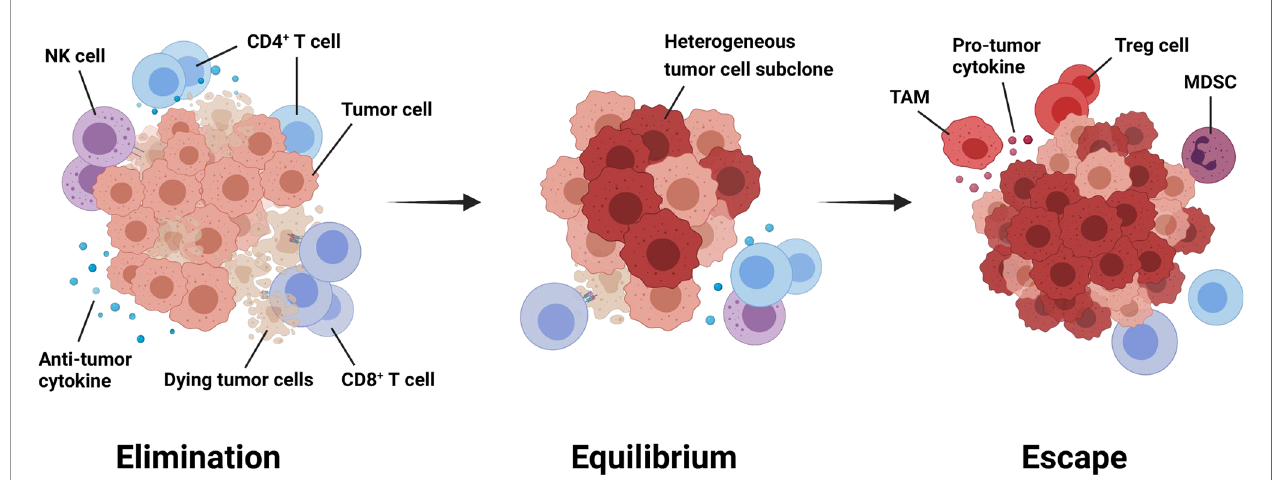
FIGURE 1 | Immunoediting throughout tumorigenesis and progression. Immunoediting generally evolves through three phases: elimination, equilibrium, and escape (14). During the fi rst phase, tumor cells activate anti-tumor immune responses, which mainly performed by CD8 + T cells, CD4 + T cells, and natural killing cells. The equilibrium phase starts if any tumor subclones survive the selection pressure from the host immunity. Tumor cells can hardly be removed, but meanwhile, their progression is strictly limited in this phase. When shifting to the escape phase, tumor cells with less immunogenicity manage to avoid recognition and attack from anti- tumor immune cells through multiple mechanisms. Besides, an immunosuppressive tumor microenvironment will gradually generate to attenuate anti-tumor immunity and favor tumor progression further. MDSC, myeloid-derived suppressor cell; NK, natural killing; TAM, tumor-associated macrophage; Treg cell, regulatory T